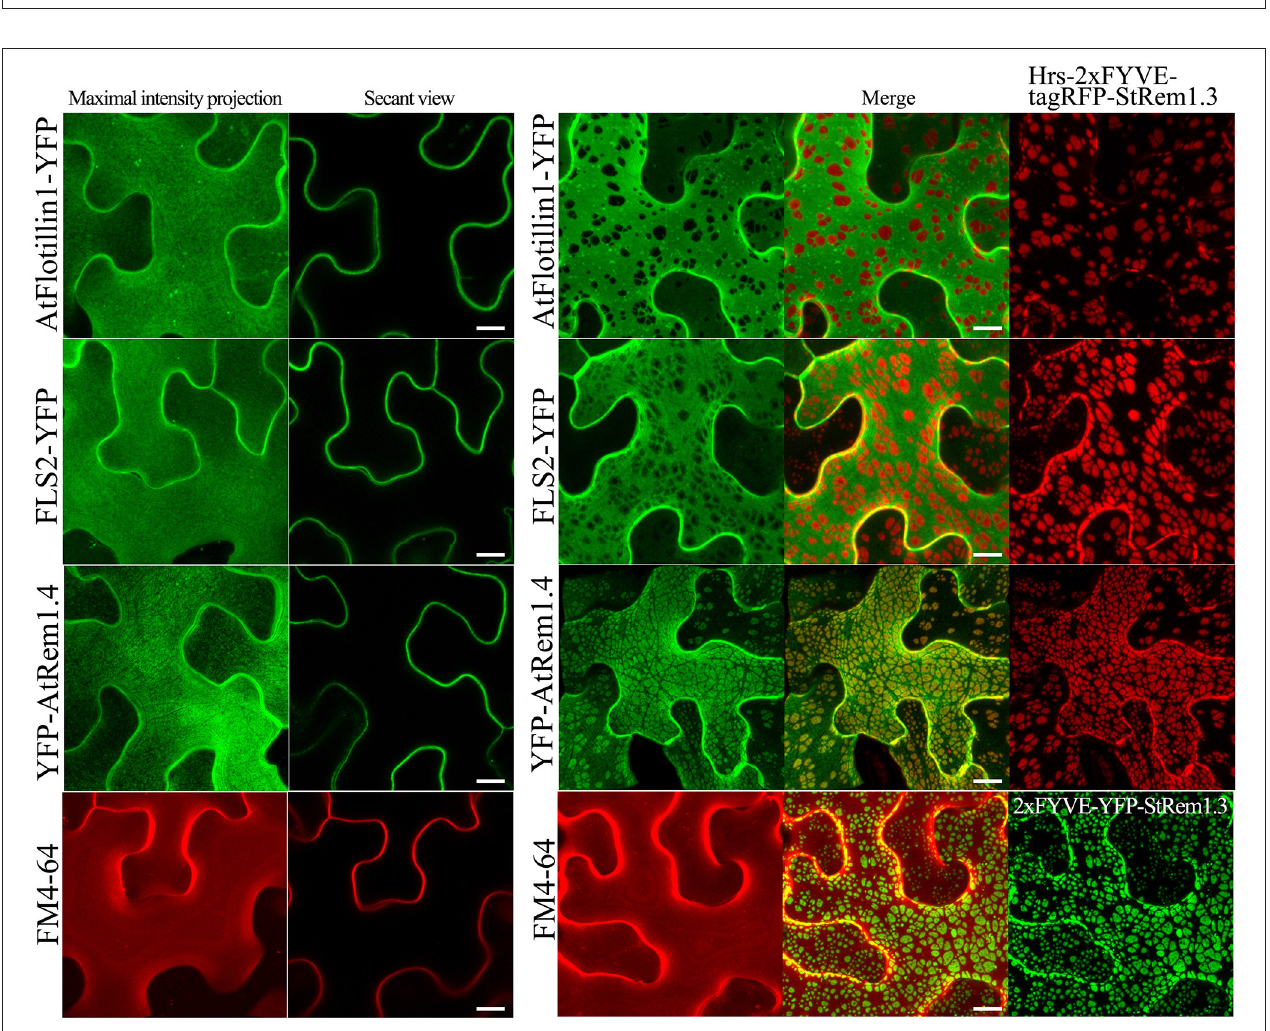
FIGURE 4 | excluded are highlighted with filled arrows, and punctae are highlighted by solid arrows. (B) Left panel: Serial z -axis sections of control cells co-expressing tagRFP and AtDMP1-GFP Right panel: Serial z-axis sections of cells co-expressing tagRFP and AtDMP1-GFP together with the fusion protein VAM7-PX-YFP*-StRem1.3 that produces colorless, negatively-stained patches. The sections reveal that the cytoplasm overlaps patches associated with MVBs, but not with patches associated with the tonoplast. Examples of tonoplast- and MVB-associated patches are highlighted with dotted and solid squares, respectively. The Z-axis image scanning interval was 0.6 µ m. Animations of serial z -sections shown in the left and right panels can be viewed in Supplementary Movies S2 , S3 , respectively. (C) An explanatory model for the distribution patterns of soluble cytosol, the vacuole, tonoplast, and MVBs in the presence of colorless membrane patches as observed in the right panel of (B) . Explanations of tonoplast- and MVB-associated patches are highlighted with dotted and solid squares, respectively. Scale bars in (A,B) , represent 10 µ m in each case.